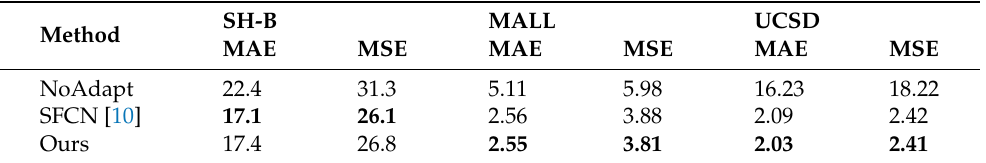
Table 2. The results for our methods on three different real-world datasets. We compare with baseline without adaptation and SFCN [10] (state-of-art)